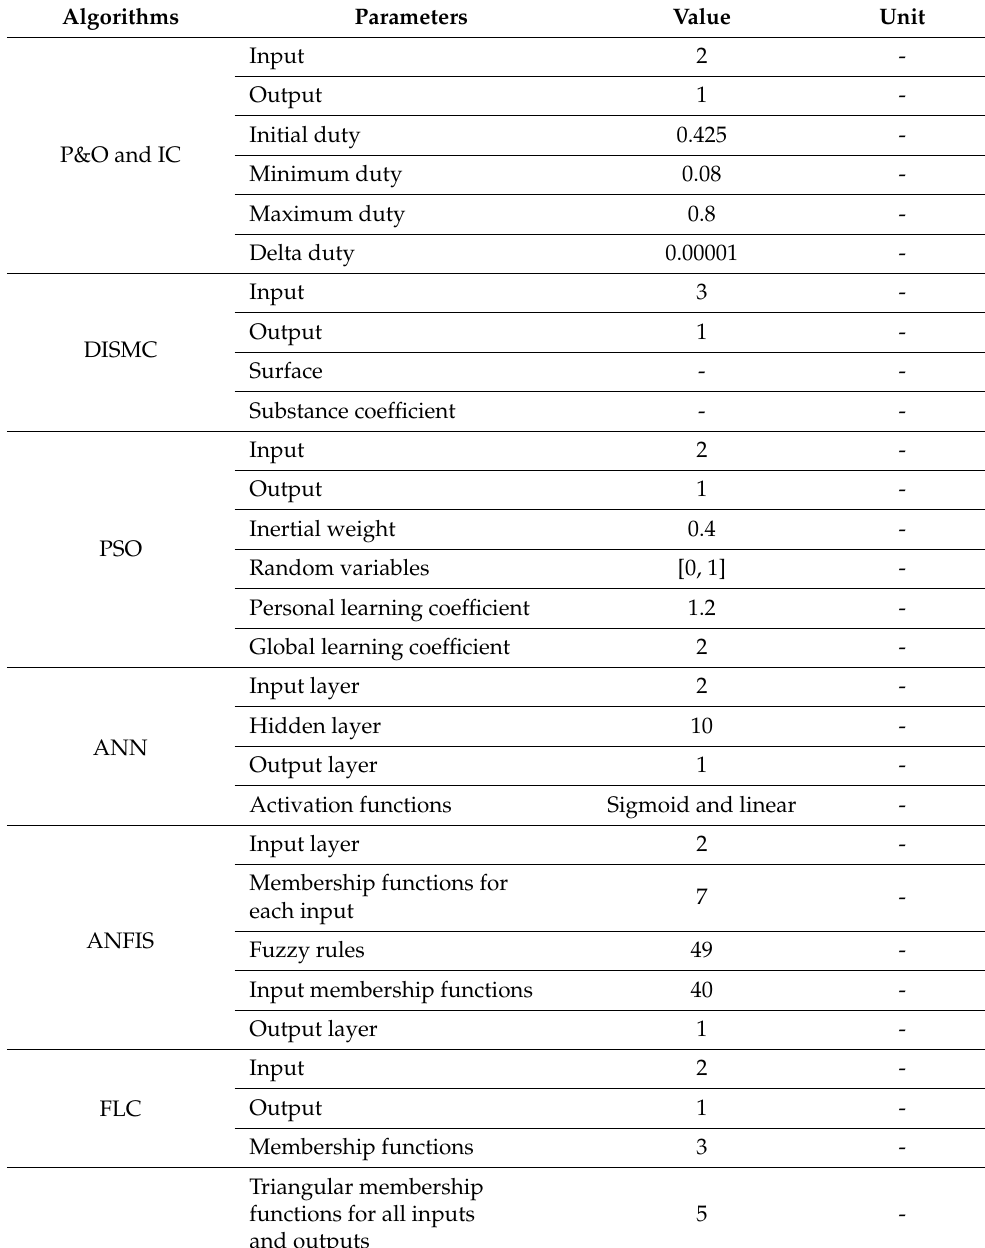
Table 8. Parameters needed to simulate the MPPT